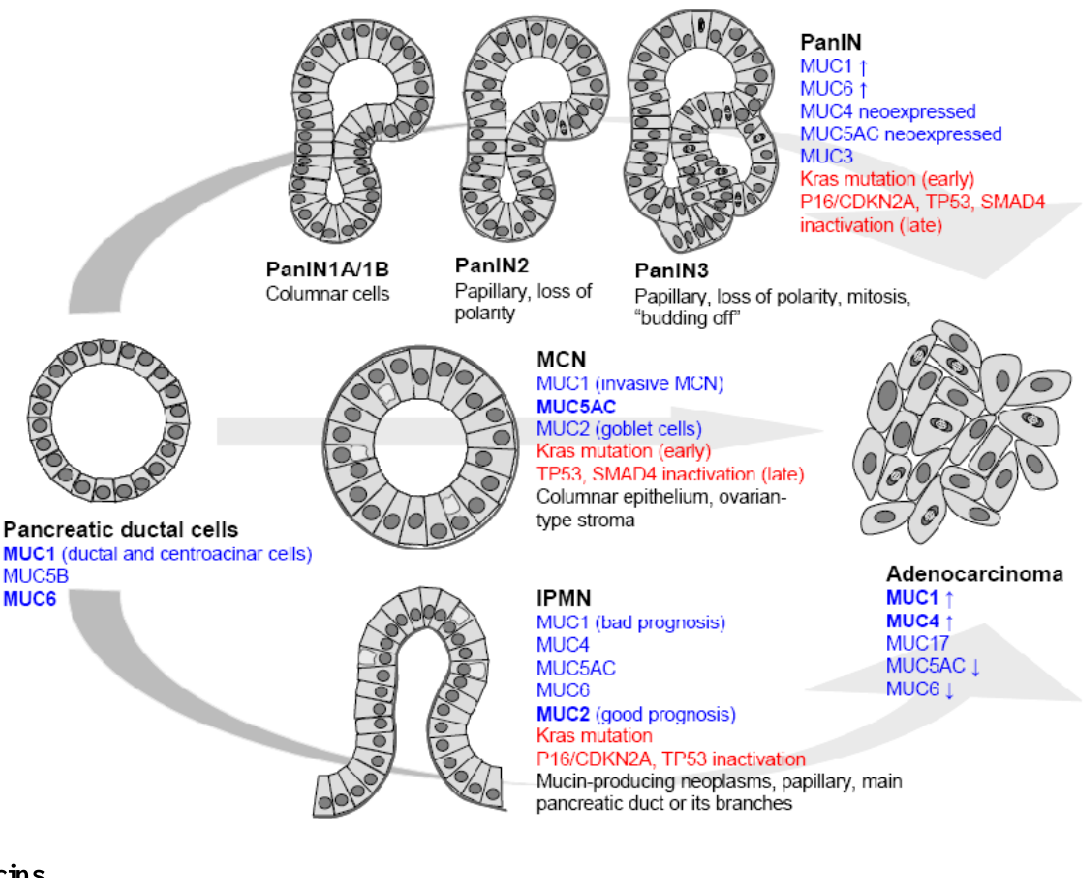
Figure 1. Mucin expression in precursor lesions leading to pancreatic ductal adenocarcinoma. Pancreatic intraepithelial neoplasia (PanIN), intraductal papillary mucinous neoplasm (IPMN) and mucinous cystic neoplasm